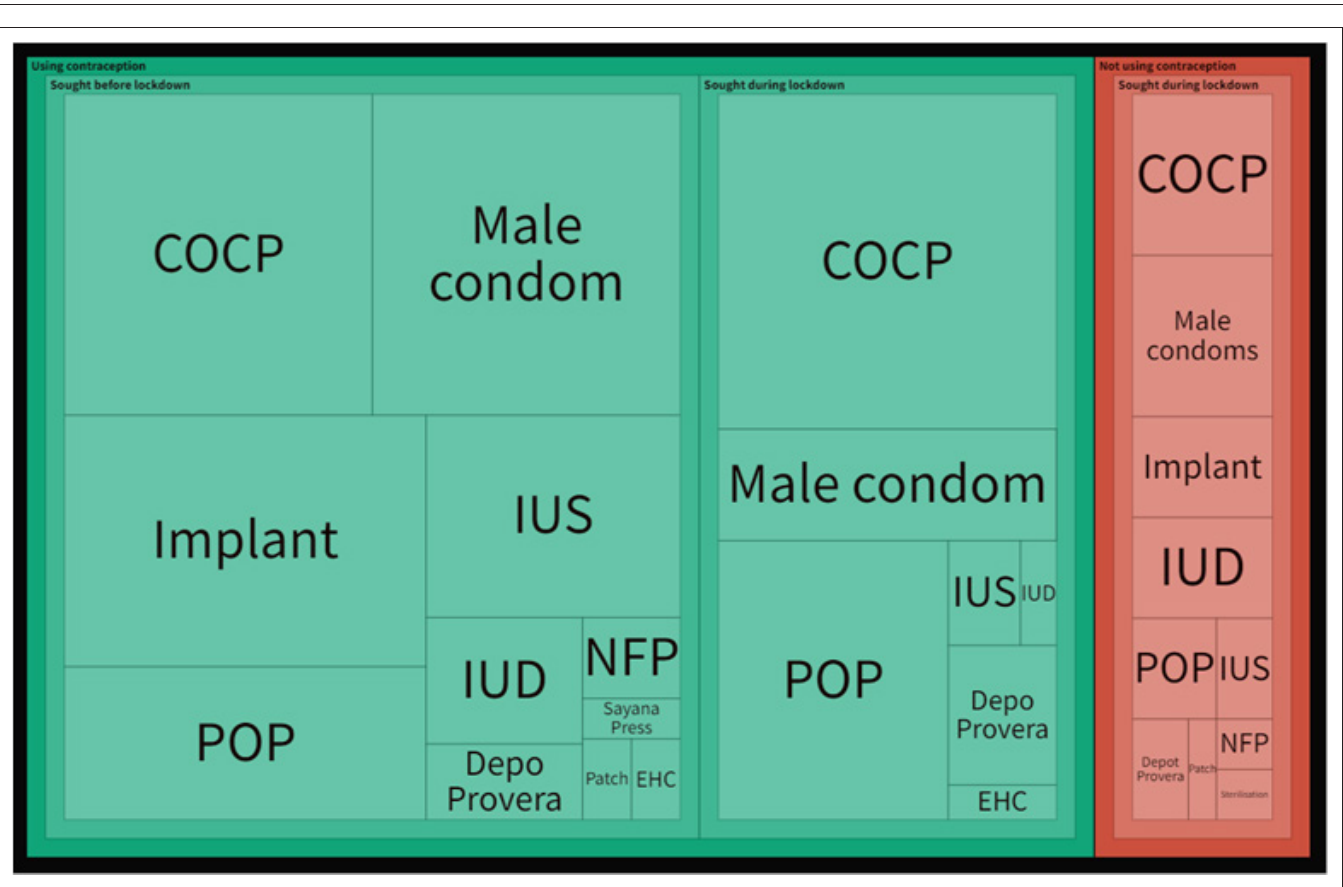
Figure 1 Tree diagram summarising contraception used or sought by responders at the time of survey. Size of each box corresponds to the number of women using or seeking that method. Long- acting reversible contraceptive (LARC) methods include: implant, IUD, IUS, Depo- Provera, and Sayana Press. COCP = combined oral contraceptive pill. EHC = emergency hormonal contraception. IUD = intrauterine device. IUS = intrauterine system. LAM = lactational amenorrhoea method. NFP = natural family planning. POP = progestogen- only